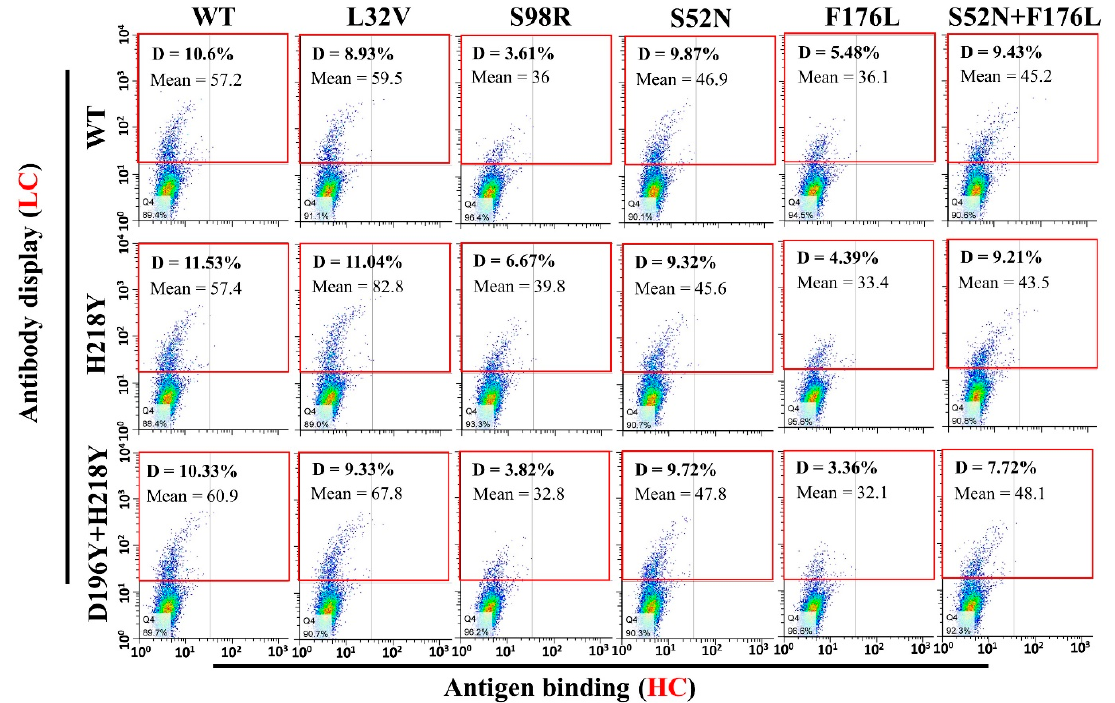
Figure 4. Antibody mutants display on cell surface and binding with HMGB1-GFP. Various antibody light chain and heavy chain mutants with trans-membrane domain were co-transfected into H1299 cells. Two days after transfection, cells were stained with anti-human-IgG-APC and HMGB1-GFP. Antibody display was evaluated by flow cytometry (Gate D: Positive Cells). The heavy chain S98R and F176L mutant combinations groups have much fewer cells display the antibody on the cell surface (Gate D, S98R: 3.6–6.6%, F176L: 3.35–5.45%) than other heavy chain mutant combinations (Gate D, 7.7–11.5%). WT: Original wild type antibody.